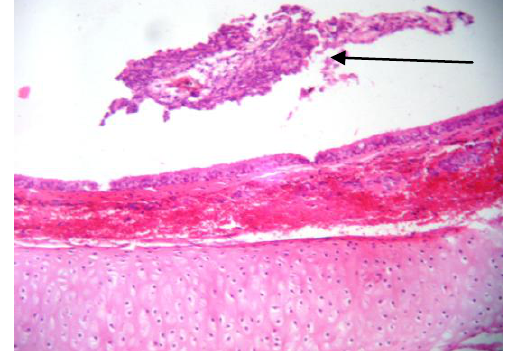
Fig (7): trachea at day 3 pi. showed inflammatory exudates in the lumen consist from neutrophils & lympho cytes in addition to tissue deprise ( ) ( H&EX10).